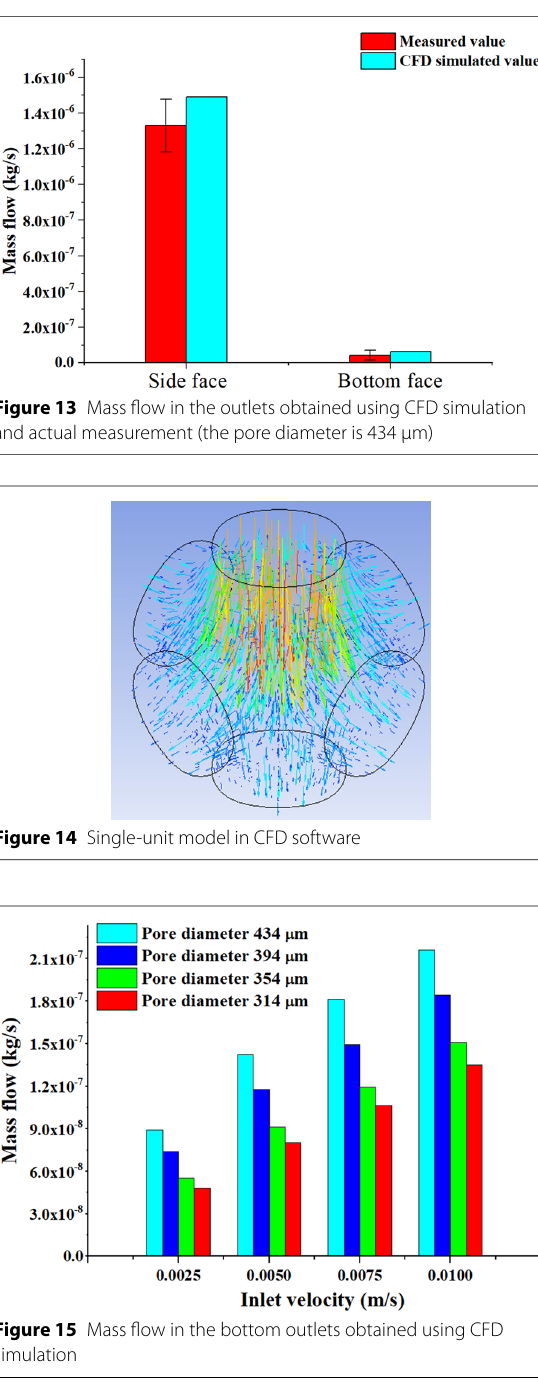
pore diameter. From this perspective, the mass flow in each outlet (bottom or side) was not uniformly distrib- uted. Therefore, in the future studies, our perfusion bio- reactor will be improved, and the dynamic cell culture